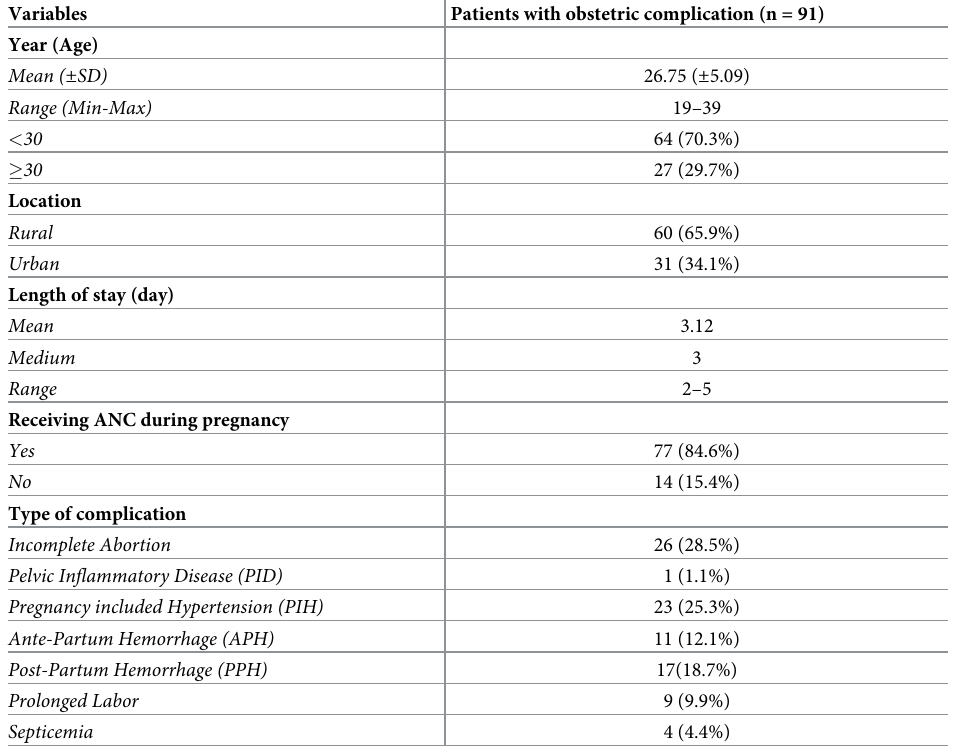
Table 1. Demographic data of hospitalized patients with obstetric complication in Yedashae township hospital (2015 fiscal